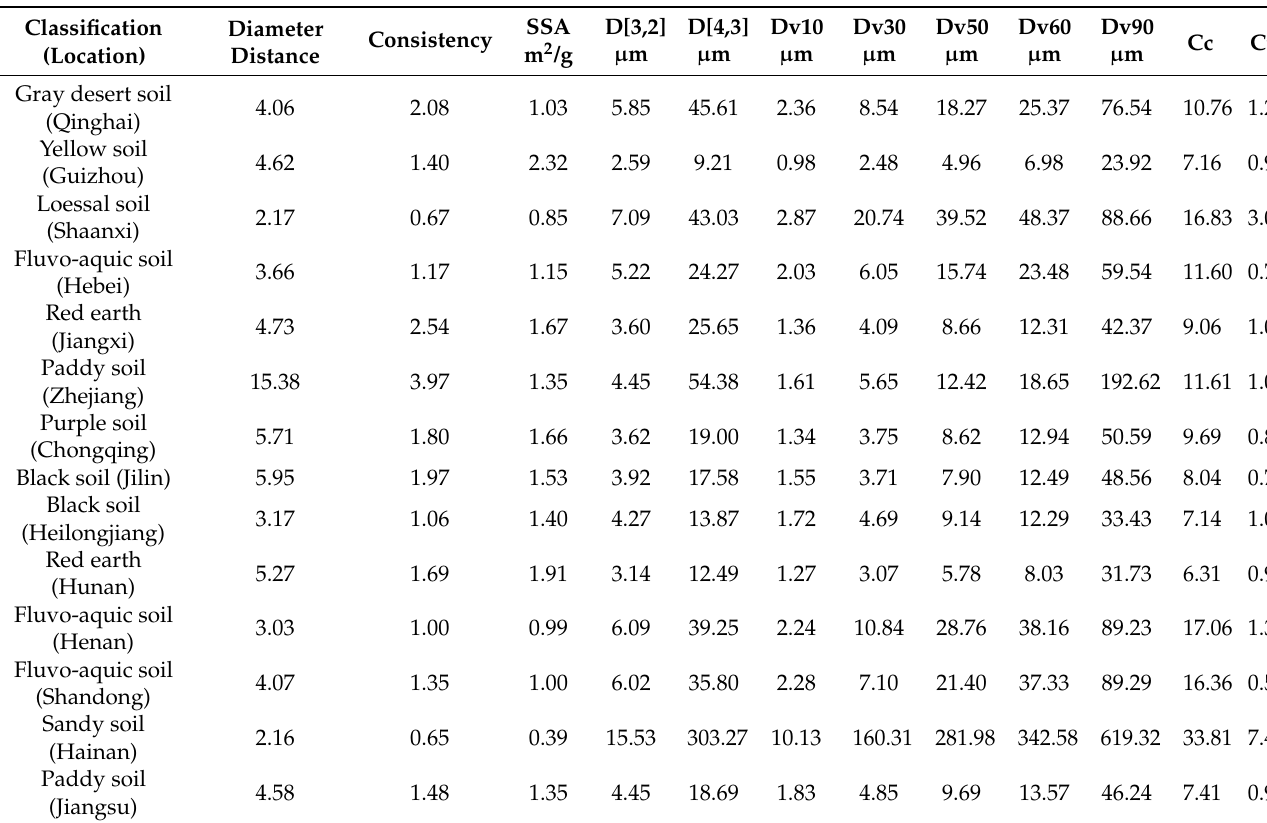
Table 2. Characteristic parameters of soil particle size distribution of fourteen types of